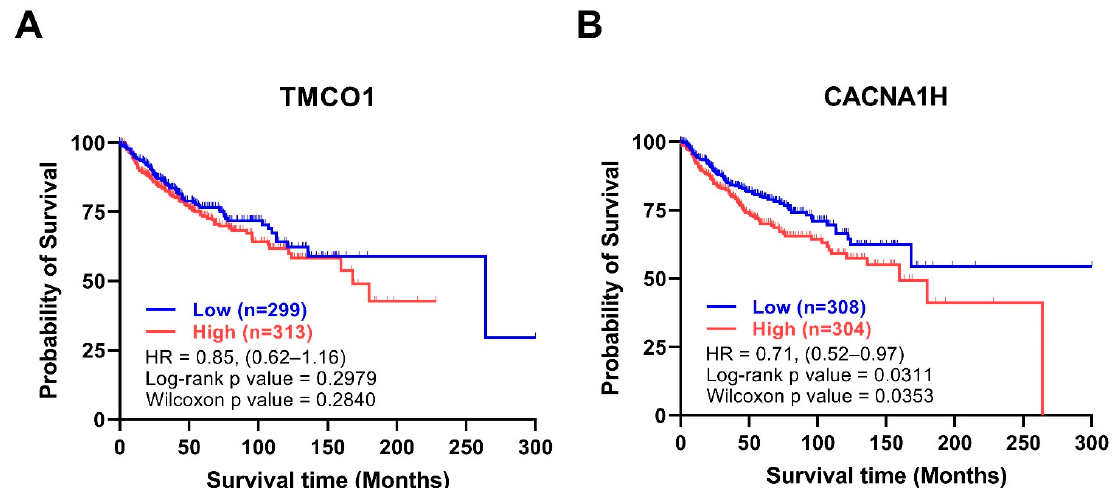
Figure 4. Kaplan Meier survival curves of the upregulated genes. Stratification of patient overall survival based on ( A ) TMCO1 and ( B ) CACNA1H expression in the Cavalli dataset [20]. Data were exported from GlioVis and plotted in GraphPad PRISM. The Y -axis represents overall survival probability, and the x -axis represents follow up in months, Blue: low expression, red: high expression, the number of patients of high and low expressions are shown between brackets, HR and p -values are shown in the graph, the total number of patients is 612. Table 3. Summary of the association of the expression level of the 16 Ca 2+ regulator genes with MB molecular subgroups and metastasis and survival rates. Genes Expression Level in MB G3 G4 Patients with ↑ Gene Expression TMCO1